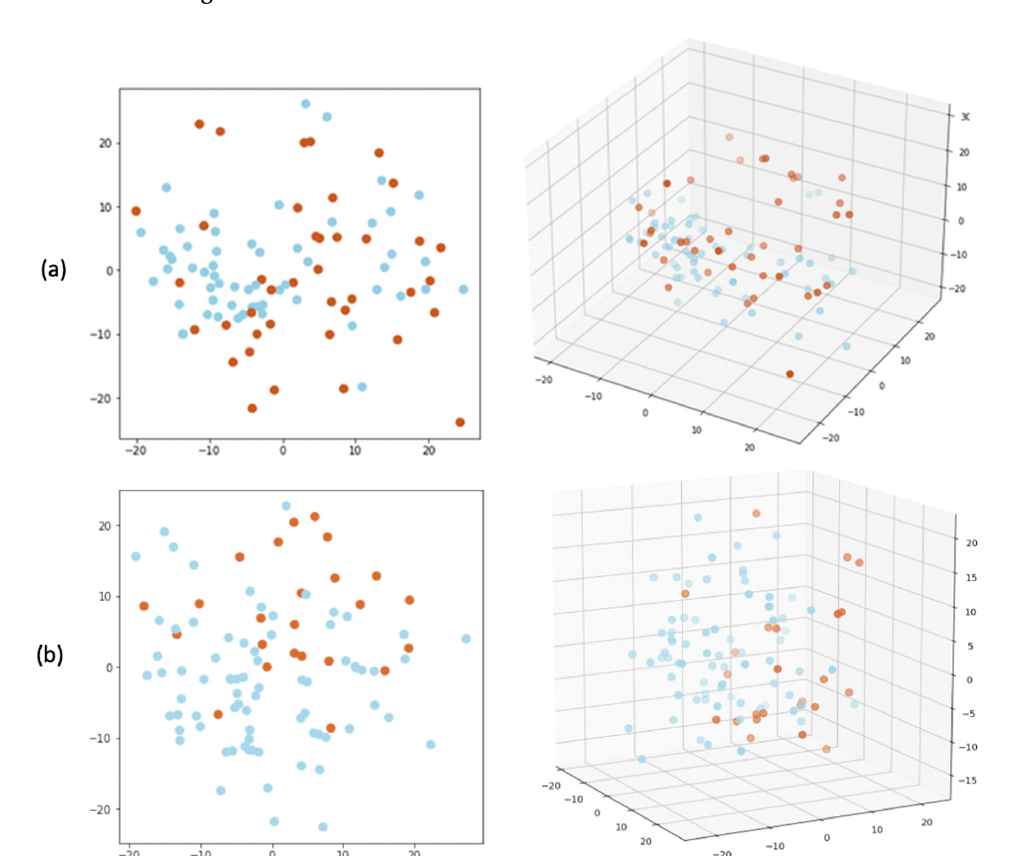
Figure 14. Unsupervised clustering visualization using SOM: ( a ) session number 3 and ( b ) session number 5 of all users.